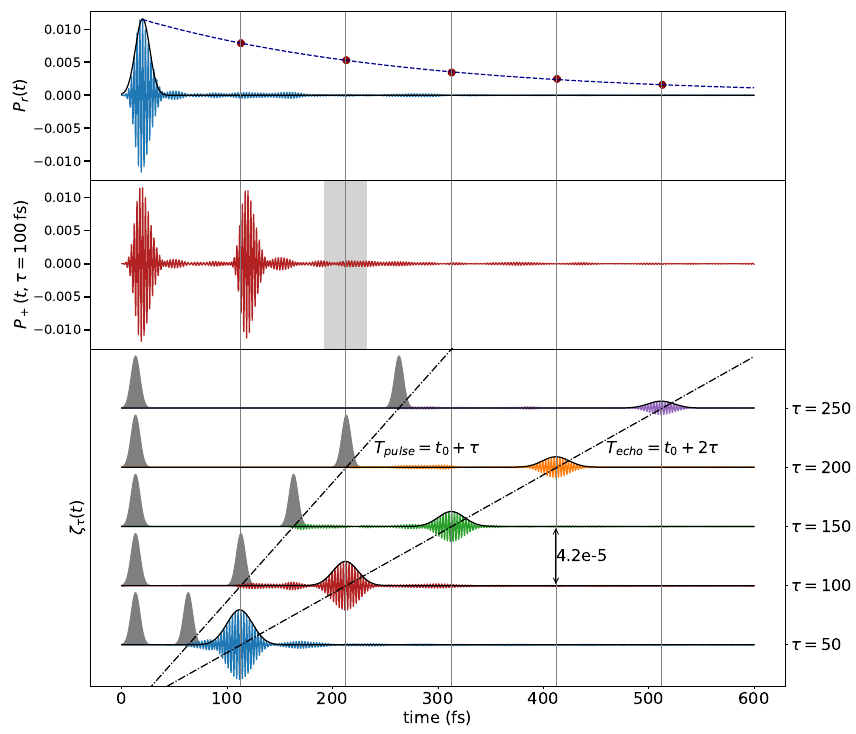
Figure 2: Real-time behavior of the ab initio polarization and echo signals. (Top) The blue curve represents the reference polarization due to the action of the pump field only. The blue-dashed line describes the time decay of the signal as expected = 250fs. The black continuous line shows the from the physical dephasing time T 2 Gaussian fit of the real-time signal, its temporal width denotes an effective decay constant of 20 fs in agreement with the FPD expected dephasing time. The red dots represent the integrated intensity of the echo signals of the bottom panel. The plot evidences that these signals scale in agreement with the T dephasing time and are 2 not affected by the FPD mechanism. (Middle) P + signal due to the combined action of the pump and the echo fields, with a relative time delay τ = 100fs. The grey- shaded area evidences the temporal region in which the echo signal is expected to be generated. (Bottom) Echo signals, extracted according to the formula (4), for various values of the delay τ (specified in the y -axis on the right side of the panel). Echos are displayed as colored curves while the profile of the pump and echo fields are plotted as a gray shaded areas. The vertical arrow shows the order of magnitude the echo